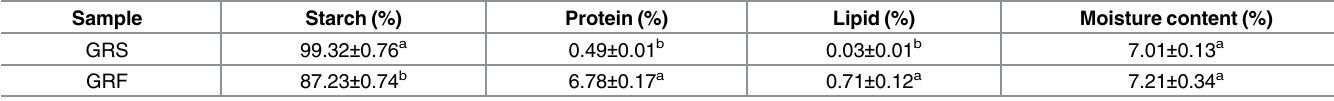
Values of means followed by different lowercase letters in the same column are signi fi cantly different ( p < 0.05). Values expressed are means ± standard deviations (n = 3).